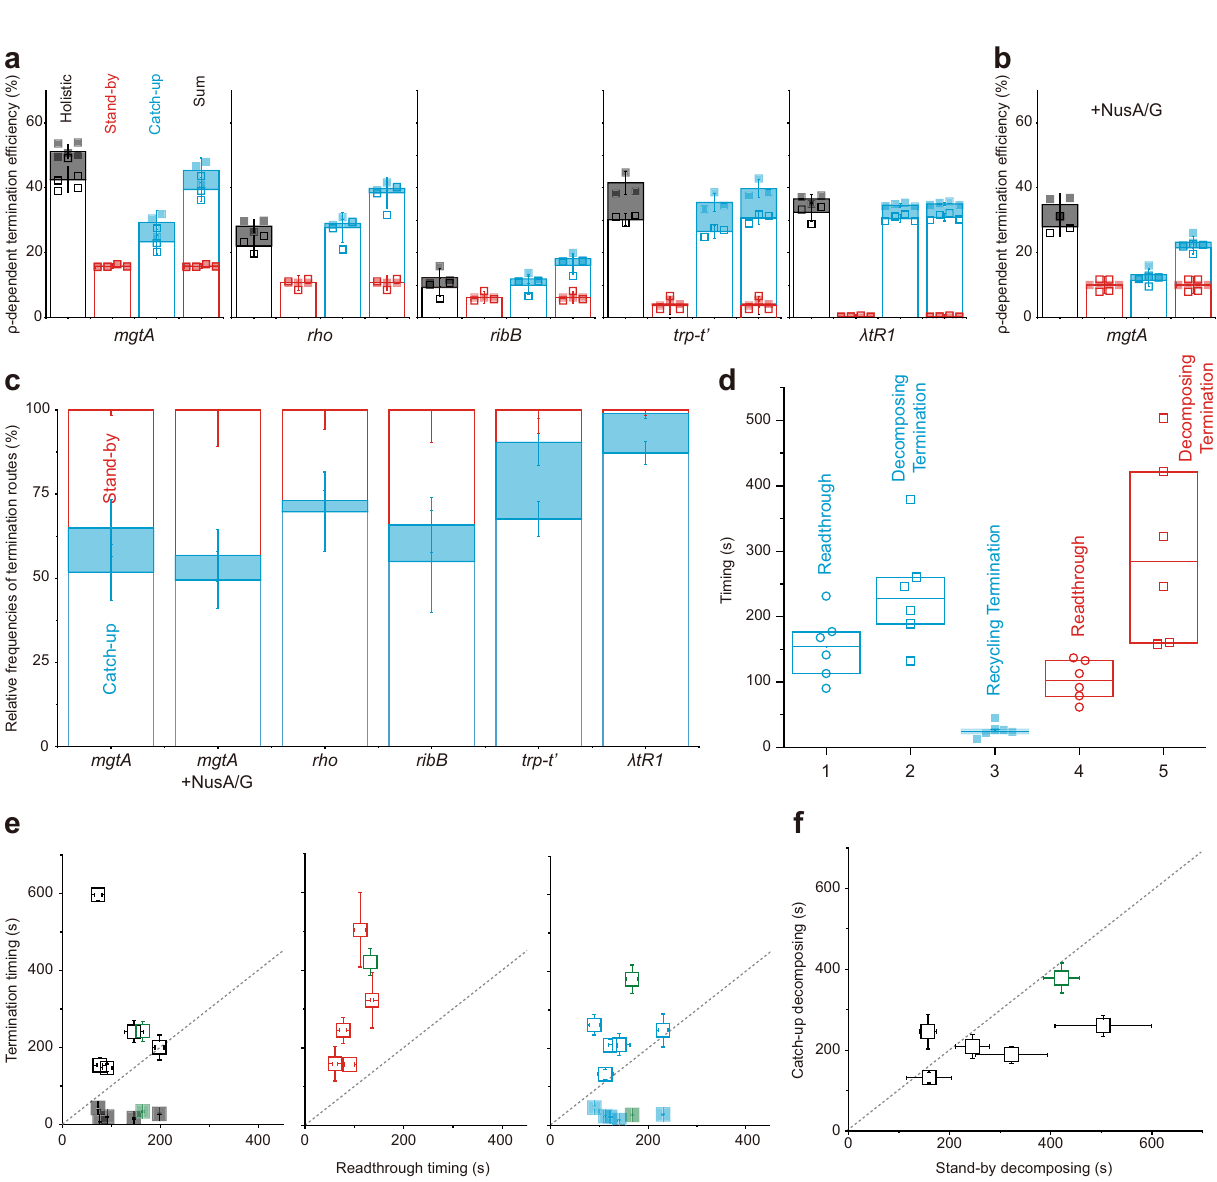
Fig. 4 Generality of ρ -dependent termination route heterogeneity. Recycling (solid) and decomposing (open) terminations were counted and timed with each of the fi ve terminators in holistic (black), stand-by (red), and catch-up (cyan) assays. a ρ -dependent TEs measured in the three different assays. The ρ -dependent TEs in catch-up and stand-by assays are summed in the rightmost bars for comparison with the holistic measurements in the leftmost bars. b The same as in a but for mgtA terminator with NusA/G. c Relative frequencies of the three termination routes. With each terminator, the frequency of each termination route in total termination events was estimated using the data in ( a ) and ( b ). The catch-up → decomposing route is the most frequent with every terminator. d Relative timings of readthrough and termination. For each transcription route with ρ , a box plot is drawn with readthrough or termination timings observed in all terminators in ( a ) and ( b ) ( n = 6), their median (centerline), and the fi rst and third quartiles (boundaries). When the timing distributions are compared among the fi ve transcription routes, the catch-up ρ ’ s recycling termination is the earliest. e Comparison between termination and readthrough timings. The average termination timings of all terminators in the y -axis are plotted against the average readthrough timings in the x -axis. The data of mgtA with NusA/G are colored green. All open squares (decomposing termination) are located above the diagonal eye-guide line with a unit slope (dotted), and all solid squares (recycling termination) below the guideline. f Comparison of decomposing termination timings between catch-up and stand-by modes. The average timings of decomposing termination by catch-up ρ in the y -axis are plotted against those by stand-by ρ in the x - axis. All open squares are located below the guideline, except for rho terminator slightly above the line. Error bar represents the standard deviation of the mean from n ≥ 3 independent experiments. The numbers of analyzed molecules for ( a ) and ( b ) are in Supplementary Table 2. Values and statistics of timings for d – f are in Supplementary Tables 3 and 4. Source Data fi le includes the data for ( a – f